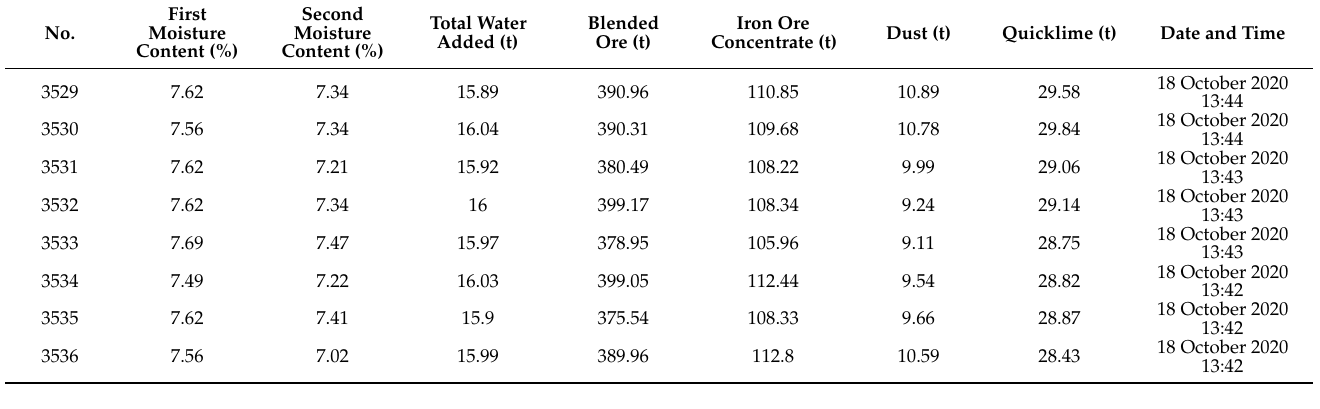
Table 1. Sample data overview.